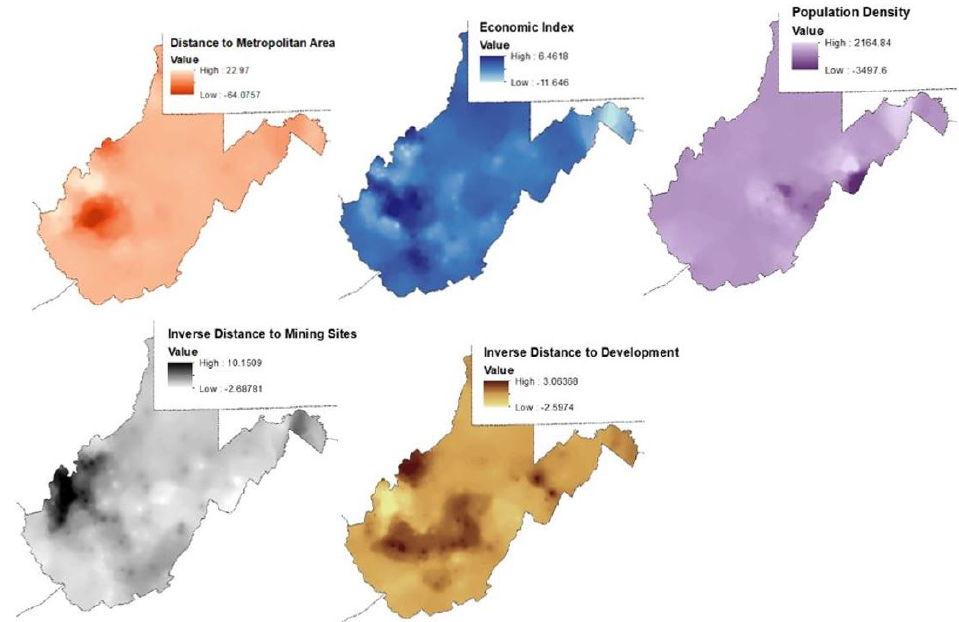
Figure 10. Geographic Coefficients for the 1985 − 1995.